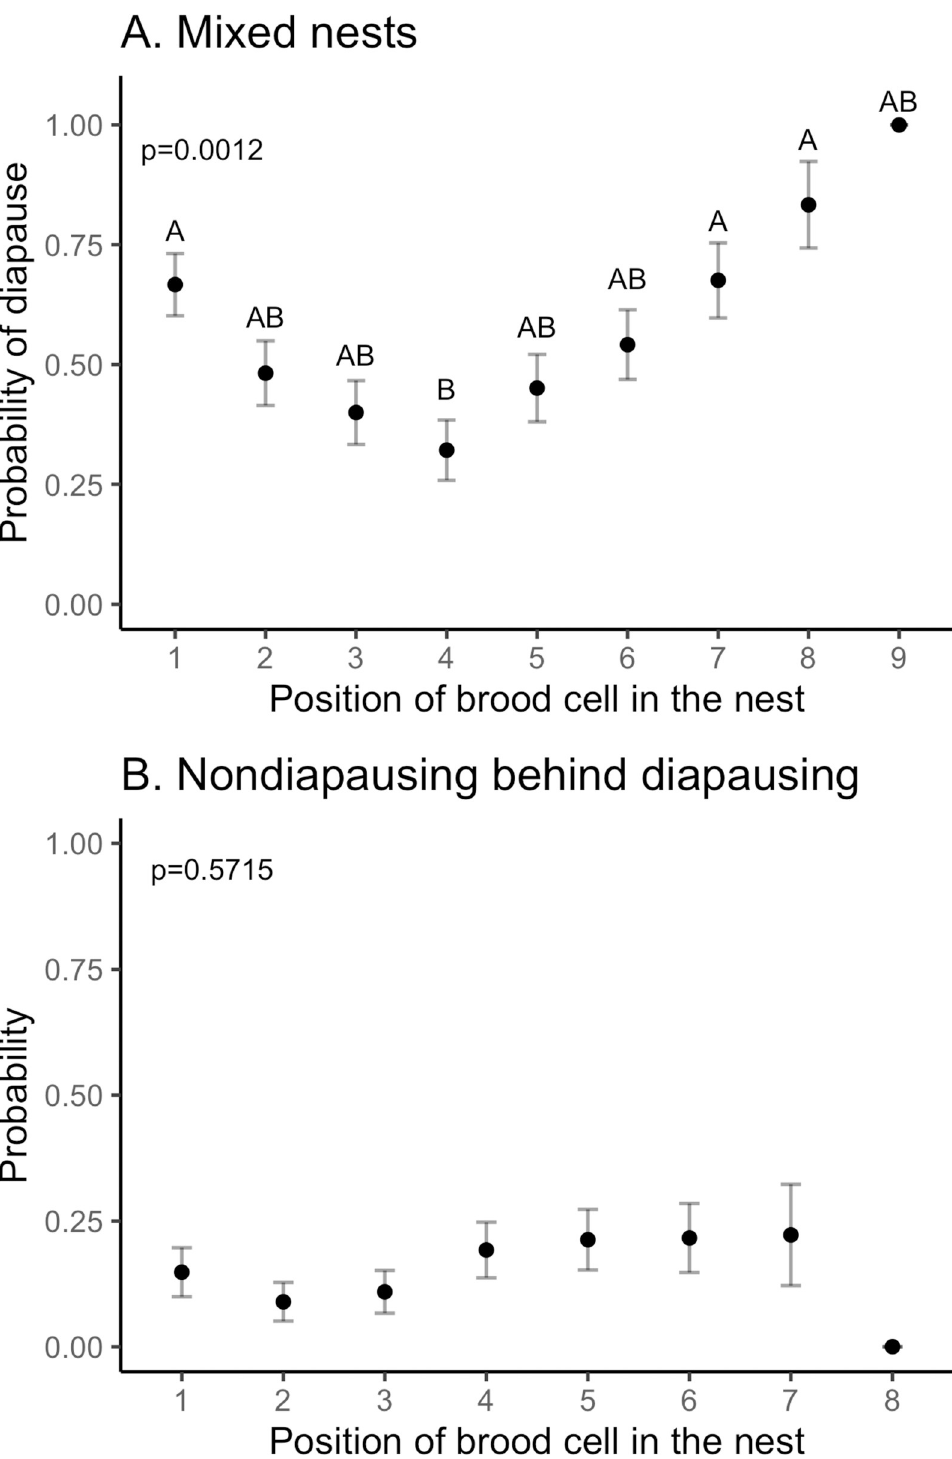
Fig 4. Mixed nests contained both diapausing and nondiapausing bees. (A) The probability of diapausing was significantly different by position of the brood cell in the mixed nests. Letters denote significant comparison by Tukey’s HSD. (B) The probability that a nondiapausing bee was laid behind a diapausing sibling was independent of brood cell position. Position one indicates the first brood cell built in the nest. Whiskers denote the standard error of the mean.